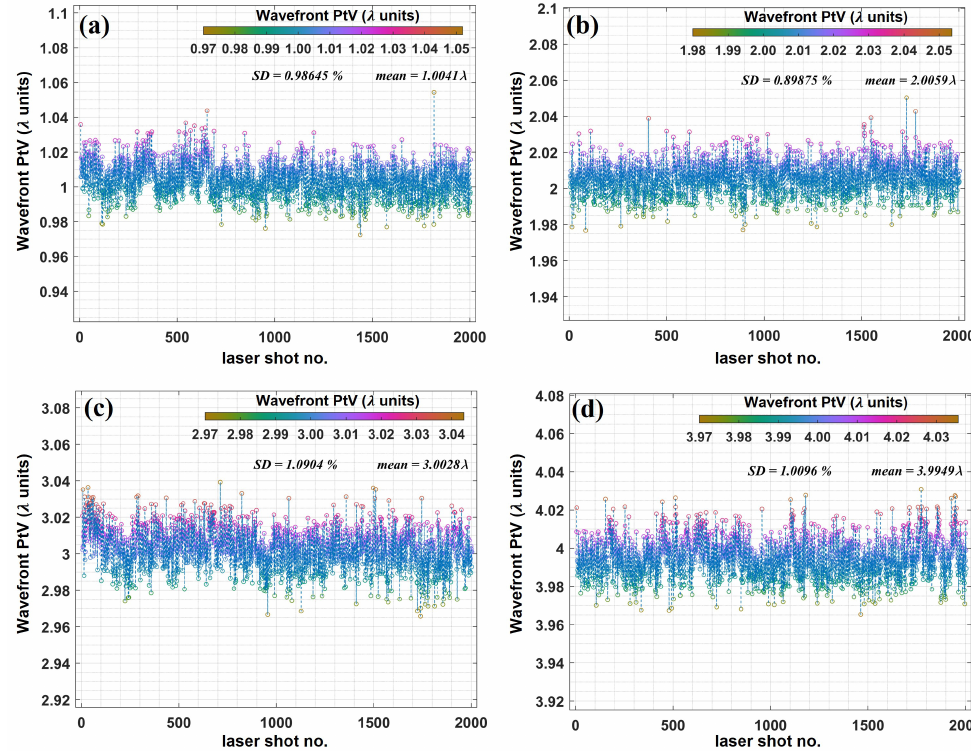
Figure 10. Wavefront twist measurement of femtosecond OV at 10 Hz repetition rate. Realtime PtV wavefront measurement over 2000 laser shots for ( a ) (cid:96) = 1, ( b ) (cid:96) = 2, ( c ) (cid:96) = 3, and ( d ) (cid:96) = 4. The mean PtV wavefront value and standard deviation (SD) of the measurement are included in the inset of each plot. In all the cases, the mean PtV wavefront indicating topological charge is within 0.5% of the theoretically expected